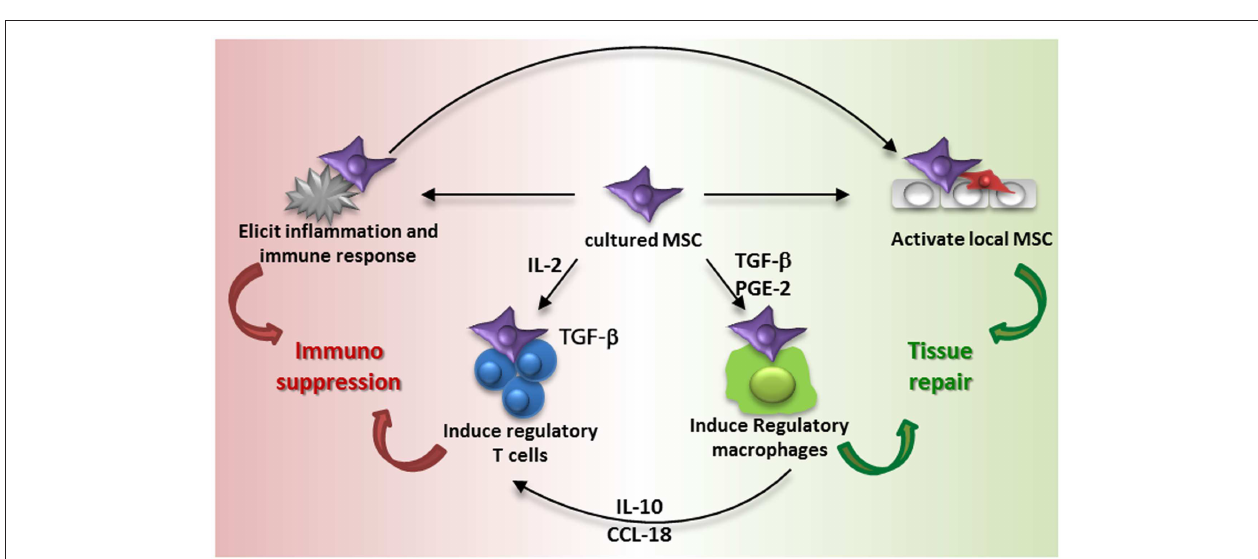
FIgure 3 | proposed model of MSc contribution to immune suppression and tissue repair. Intravenous administration of culture-expanded MSC (violet cells) leads to modulation of the function of endogenous MSC (red cells) and macrophages via the secretome of the administered cells (e.g., TGF- β , PGE-2, and other factors) and phagocytosis of MSC by